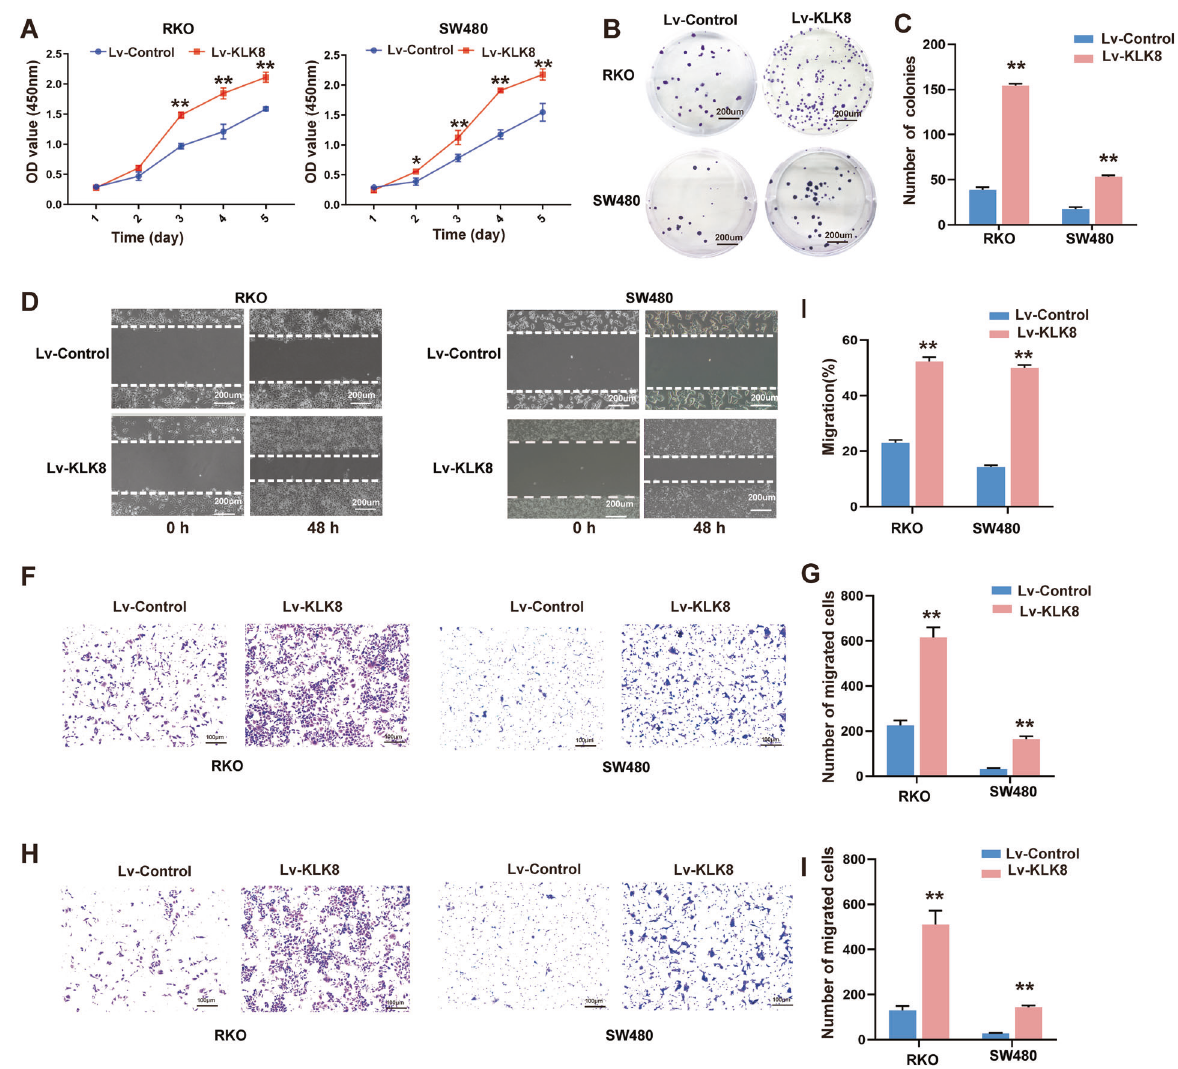
Fig. 3 KLK8 overexpression promotes the proliferation, migration and invasion of CRC cells in vitro. KLK8 overexpression was induced with recombinant Lentivirus infection (Lv-KLK8) in human colorectal cancer cell lines RKO and SW480, and an empty adenovirus served as control (Lv-Control). A CCK8 assay was used to assess cell proliferation. B Colony formation assays for the proliferative ability of Lv-control or Lv-KLK8-transfected CRC cells. The number of colonies was shown in ( C ). D , E Wound-healing assay was conducted to assay the migration of CRC cells. The wound space was photographed at 0 and 48 h. The cell migration ability was evaluated by measuring the distance between the advancing margins of cells. F − I Cell migration and invasion were determined by using transwell migration and invasion assays. All of the data are presented as the mean ± SEM from three independent experiments. * P < 0.05; ** P <